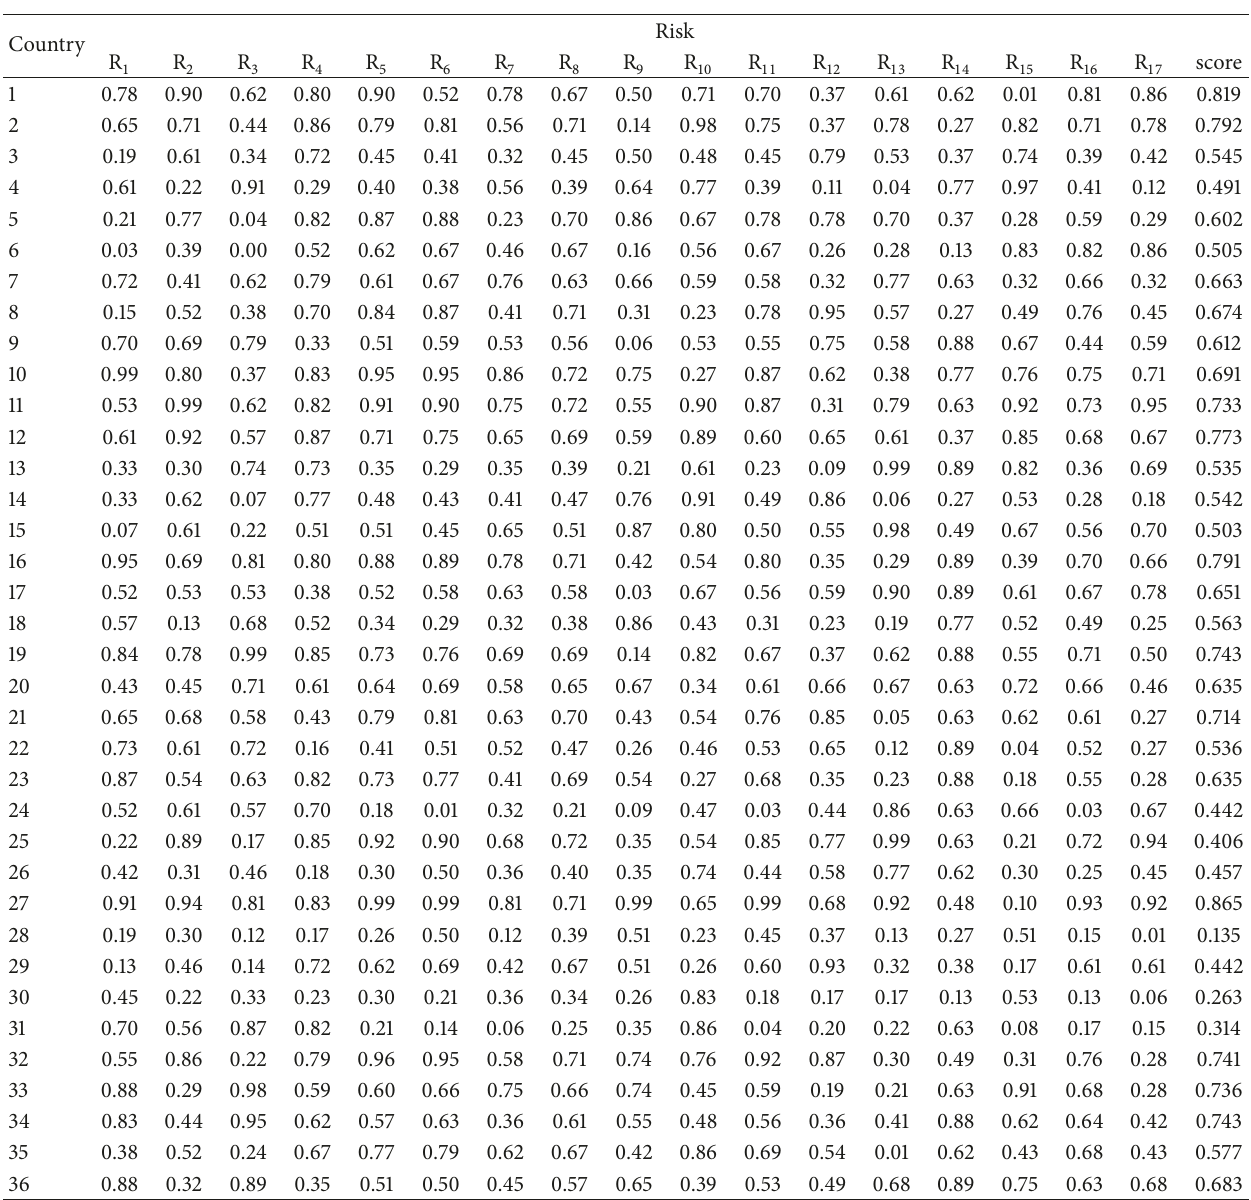
Table 3: Risk scores for railway construction projects in 36 countries in